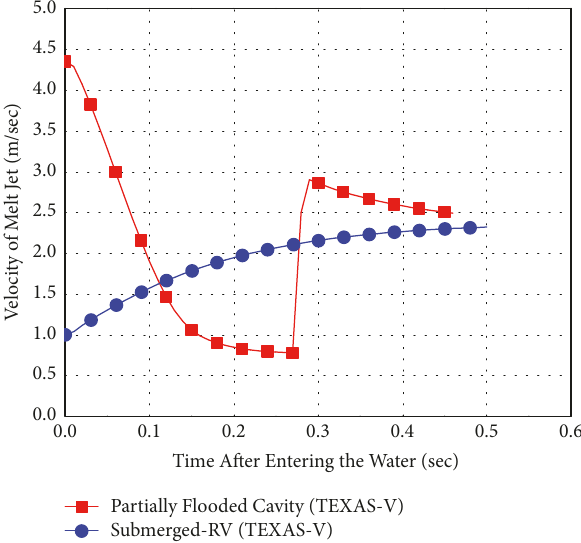
Figure 10: Variation of velocity of melt front through water in TEXAS-V